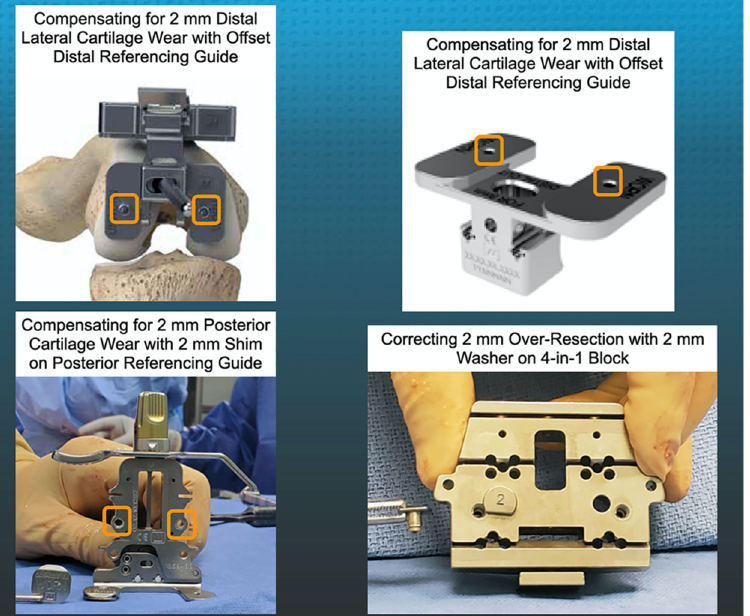
Figure 2. The composite of images shows the manual instruments used to make the distal and pos- terior femoral resections. The features include an offset distal referencing guide with two holes (or- ange squares) for compression screws ( upper left and right ), a posterior referencing guide set at 0° with small, medium, and large width posterior feet with two holes (orange squares) for compression screws and removable shims to compensate for 2 mm of distal and posterior cartilage wear ( lower left ), and a washer, available in 1 and 2 mm (shown) thicknesses, to correct for an over-resection of a distal femoral condyle ( lower right